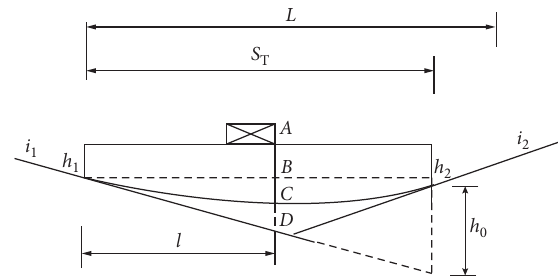
Figure 10: Sight distance under the overpass ( L ≥